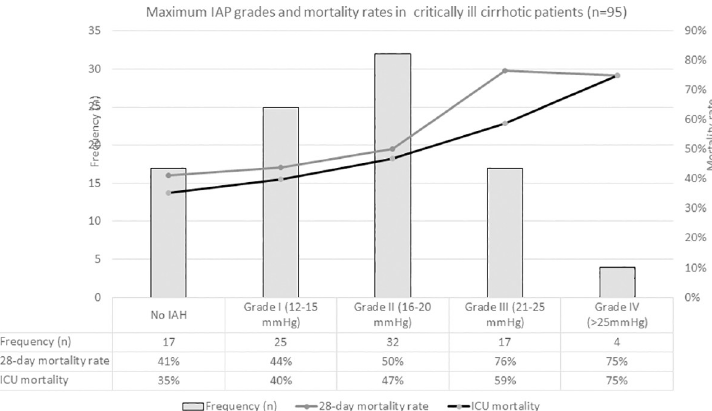
Fig 2. Distribution of IAH grades for maximum intra-abdominal pressure and mortality rates in critically ill liver cirrhotic patients. Abbreviations: IAH–Intra-abdominal hypertension; ICU–intensive care unit.